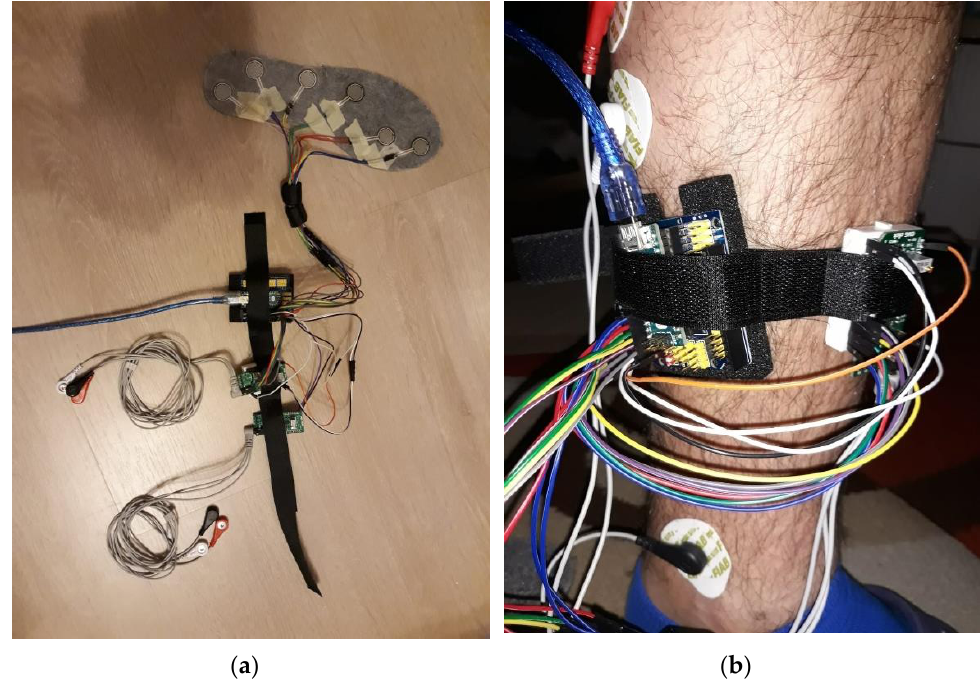
Figure 7. The wearable foot biomechanics monitoring system laboratory proof of concept: ( a ) circuit setup, ( b ) system wearing on the lower limb.